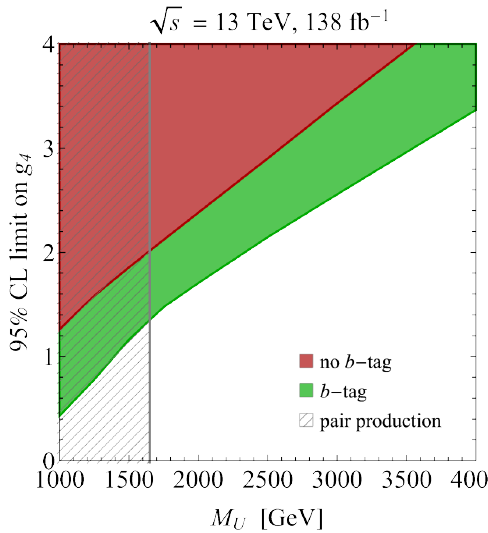
Figure 7 . Comparison of the 95% CL constraints on the M U – g 4 plane that arise from the latest LHC Run II hadronic ditau analysis [54]. The red (green) exclusion corresponds to the no b -tag ( b - tag) category of the latter search, while the hatched grey parameter space is excluded by strong pair production of third-generation LQs [113]. Consult the main text for additional